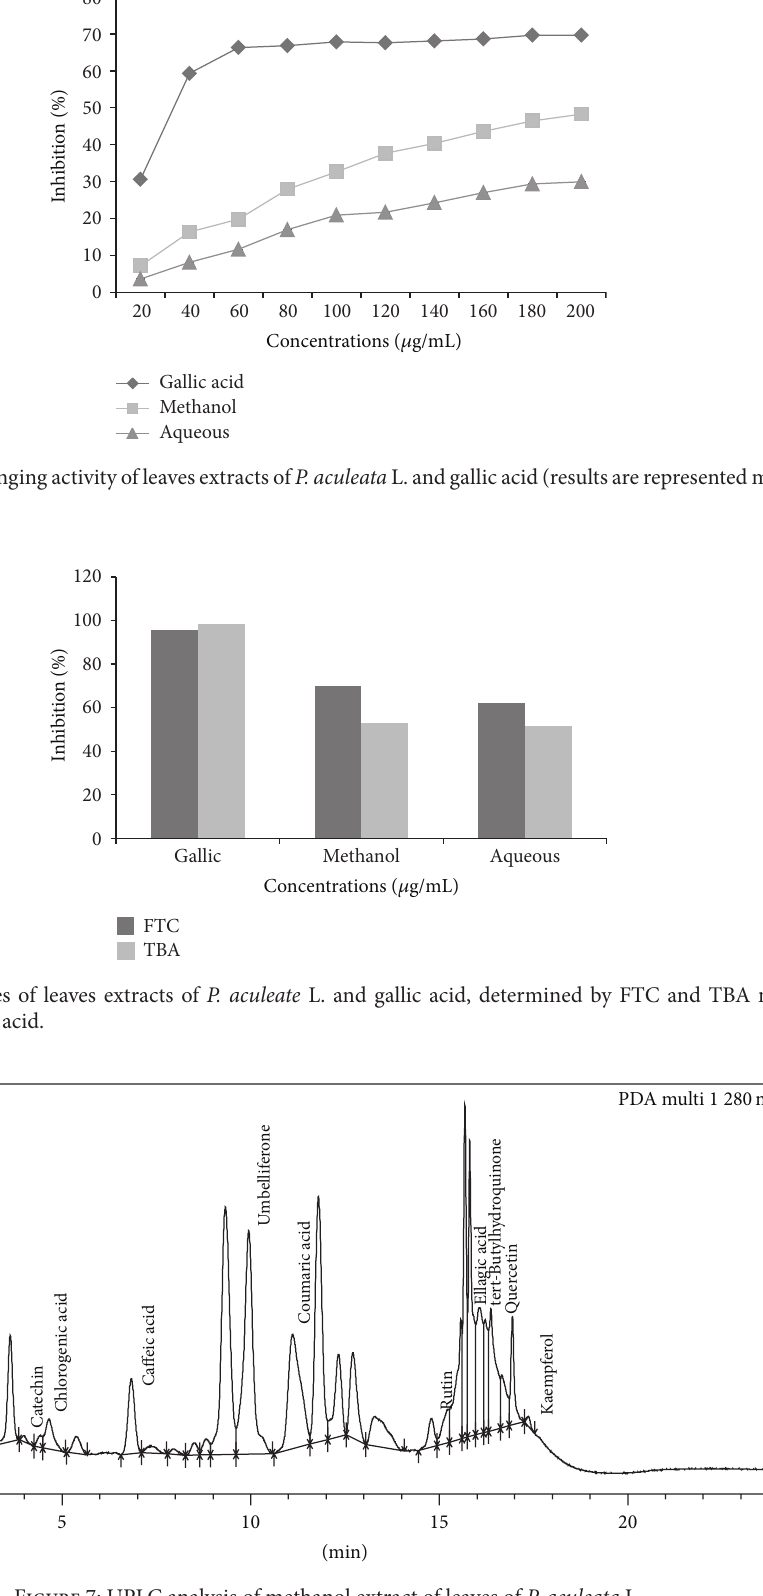
Figure 7: UPLC analysis of methanol extract of leaves of P. aculeata